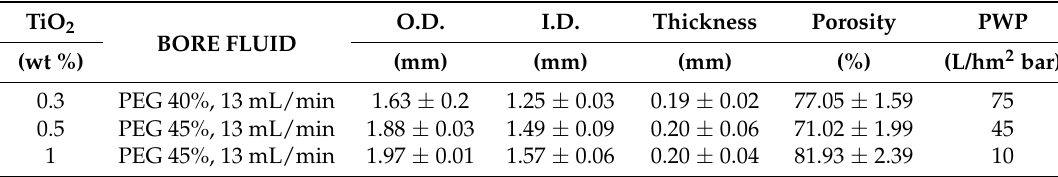
Figure 5. SEM pictures of the PES-TiO 2 hollow fibers produced at different TiO 2 concentrations. In the red circles, the TiO 2 NPS embedded in the matrix are highlighted. Table 6. Synoptic table of the PES-TiO 2 hollow fibers produced.